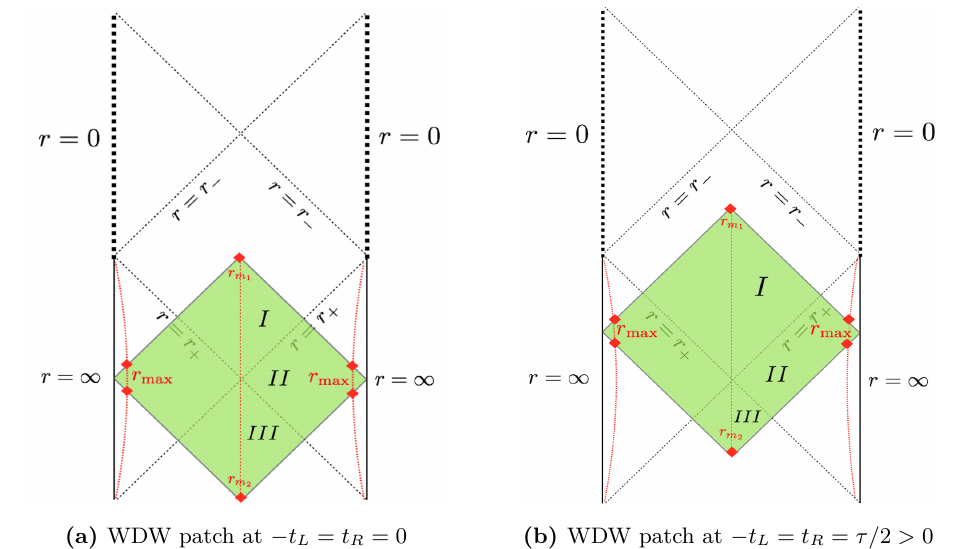
Figure 3. Penrose diagrams for the rotating black holes in (2.1) with the WDW patches corre- sponding to the TFD state at − t L = t R = 0 in (a) and − t L = t R = t/ 2 > 0 in (b) as the green shaded region. Joints contributing to the action terms are highlighted with red diamonds. Also shown are three regions I , II , and III defined for the bulk contribution to I WDW . The vertical dotted red line divides the WDW patch into two symmetric parts and define the regions I, II, and III. The curved dotted red line is the cut-off surface r = r max ( δ )